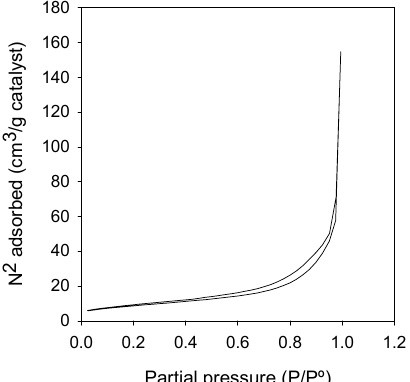
Figure 3. N 2 isotherm of the Fe 3 O 4 –SiO 2 –TiO 2 .